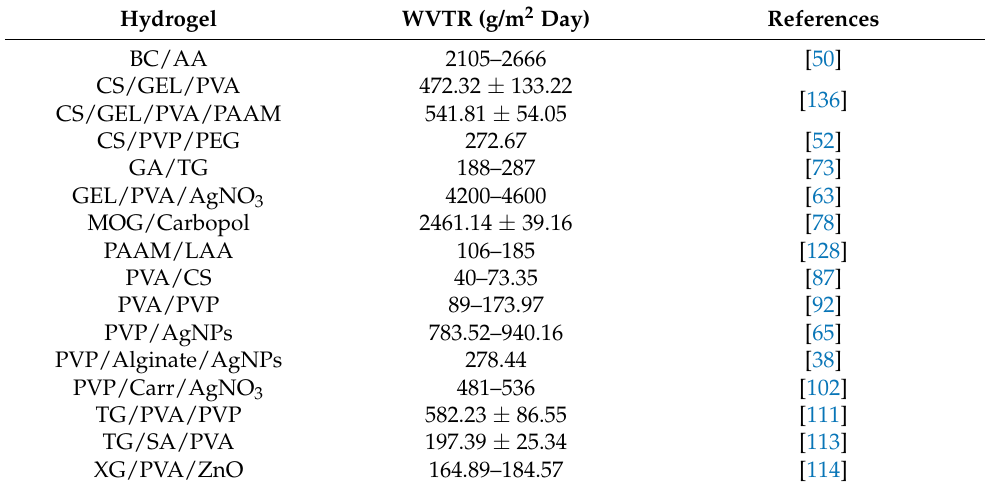
Table 3. WVTR of hydrogel wound